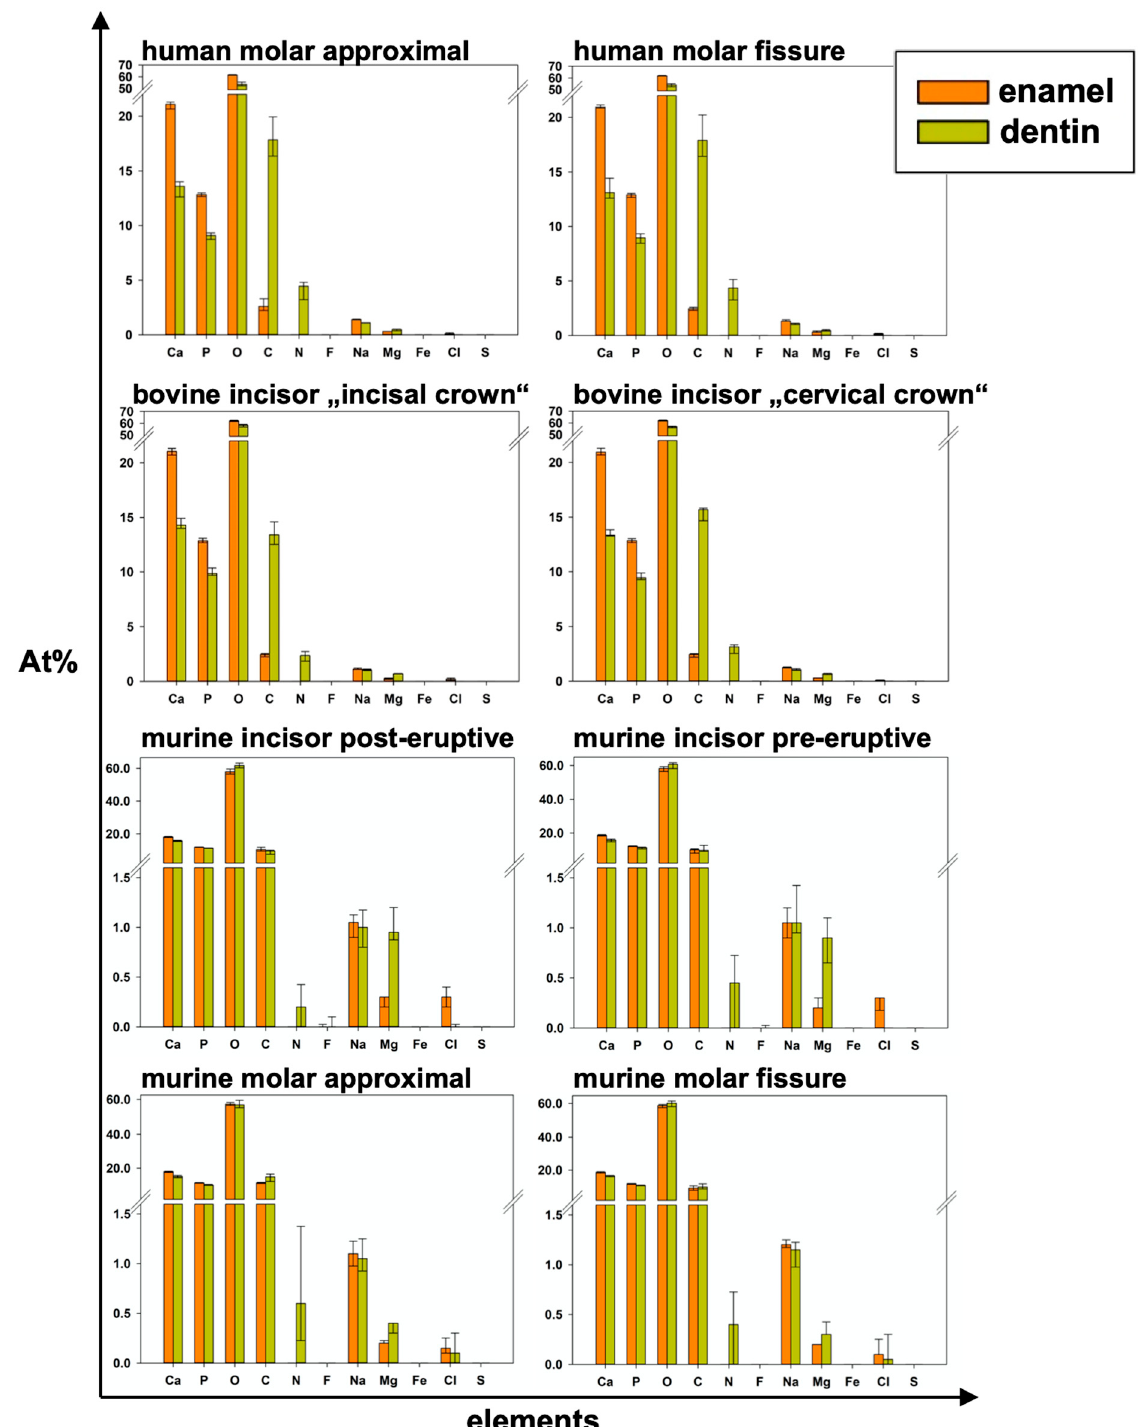
Figure 6. Elemental composition in detail for all areas and both examined dental hard tissues of each group and all elements (median and 25–75% percentiles); p -values in Table 3. At%Na was significantly higher in human enamel than in human dentin in the ap- proximal ( p = 0.002) and fissure areas ( p = 0.002) and in bovine cervical enamel ( p = 0.026). Human teeth showed the highest At%Na (1.4 At%Na in enamel) compared to bovine and murine teeth. Significantly more At%Mg was found in dentin than in enamel in all areas of all species ( p ≤ 0.015). The Ca/P-Ratio was highest in human and bovine enamel, which did not differ significantly. Murine molars showed a higher Ca/P-Ratio than